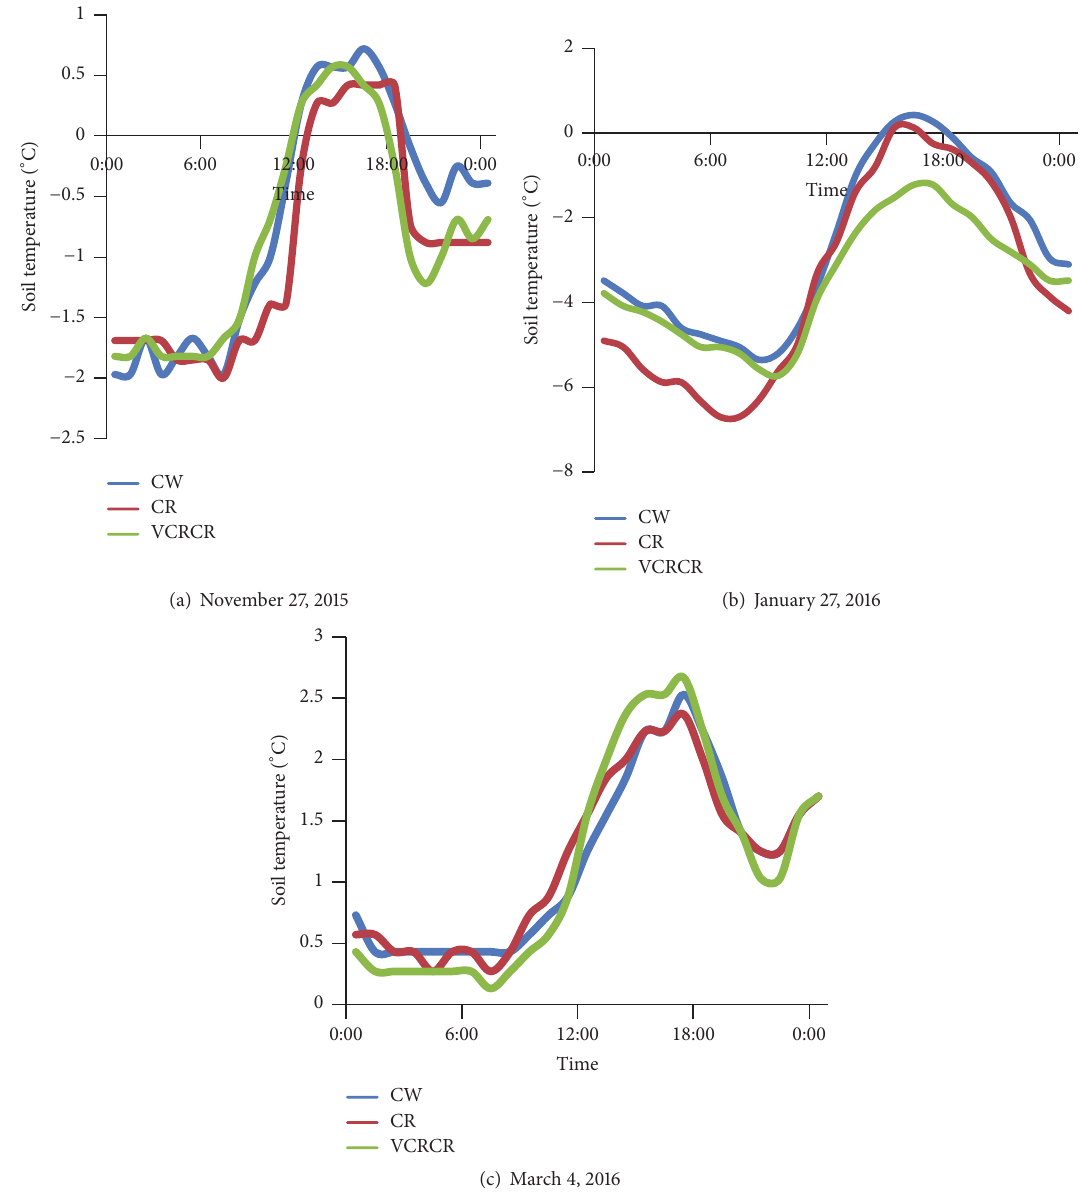
Figure 4: Temporal soil temperature changes on intrarow soil surface under different postsowing compaction treatments.